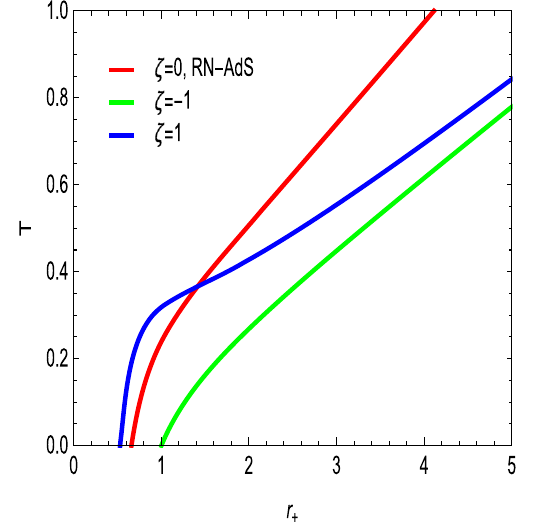
Fig. 1 Plot of T versus r + for charged BH with NED